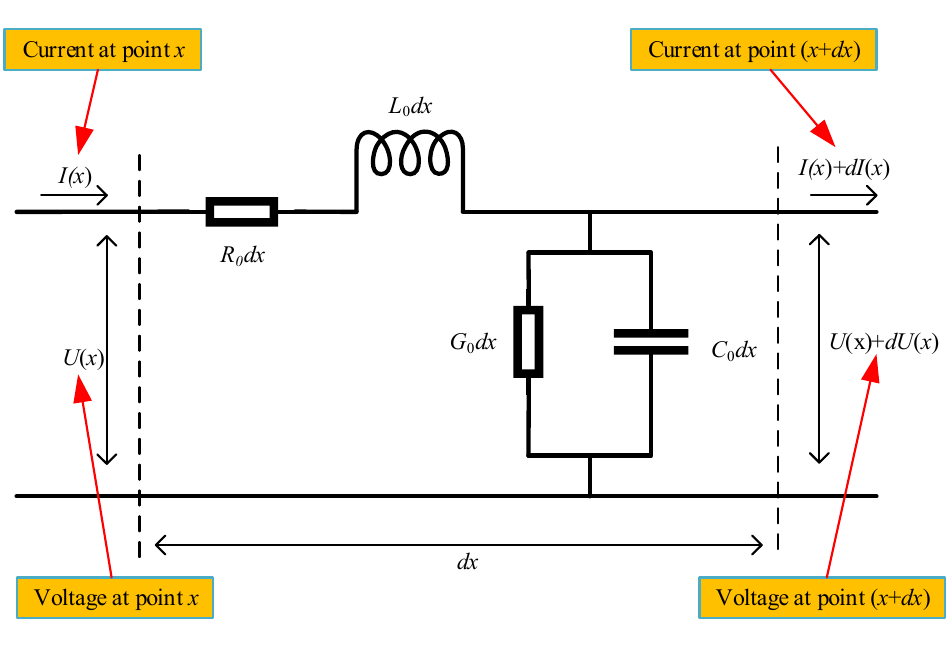
Figure 1. Г type network.